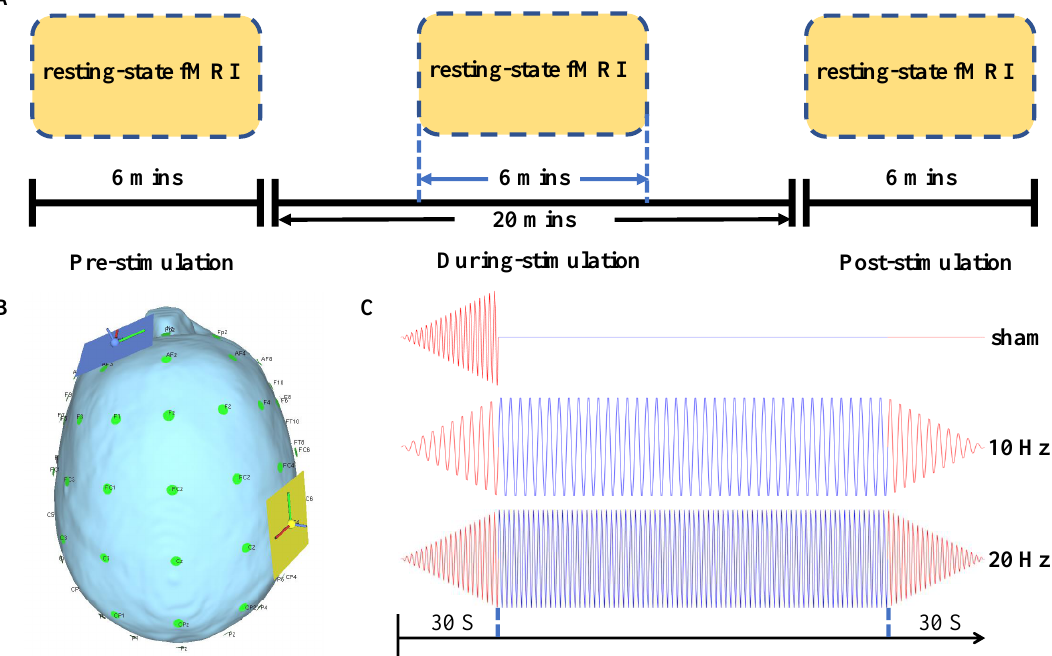
Figure 1. ( A ) The protocol of MRI acquisition and transcranial alternating current stimulation (tACS) intervention. ( B ) The montage of stimulation electrodes (drawn by SimNIBS [22]). The yellow one was put on the ipsilesional primary motor cortex, and the blue one is on the contralesional supraorbital ridge. ( C ) The currents of sham, 10 Hz, and 20